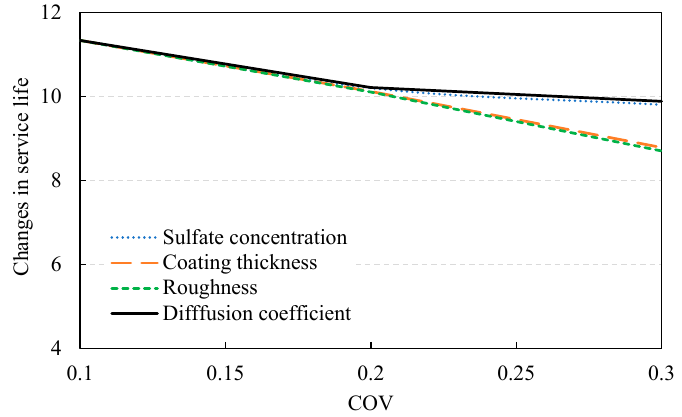
Figure 13. Decreasing service life with increasing COV.